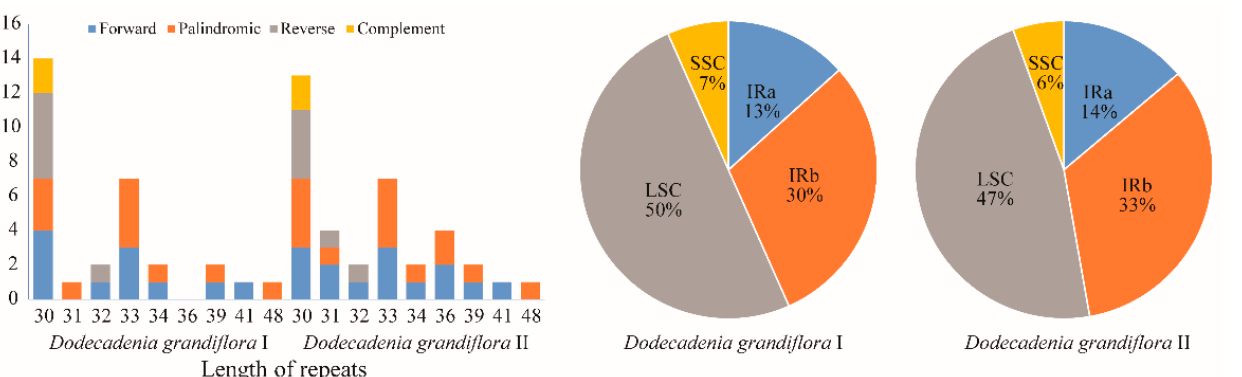
Figure 3. The prediction of RNA editing sites number and amino acid changes.